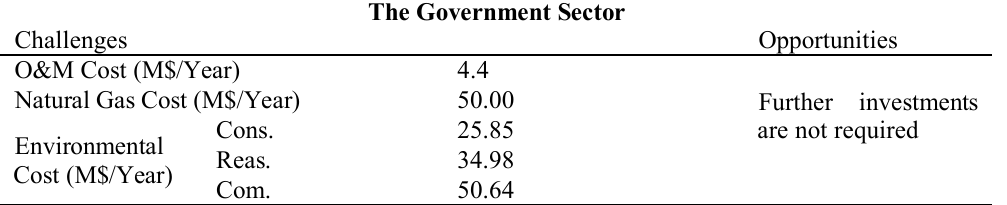
Table 12 . Economic opportunities and challenges of the government sector (INGC) at the current condition of Polkalleh CS – The 1st Scenario